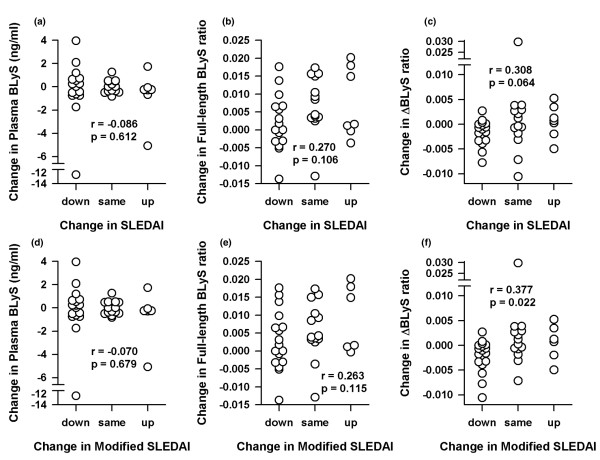
Correlations in SLE patients between changes in SLEDAI and BLyS parameters. Individual (a,d) BLyS protein levels, (b,e) full-length BLyS mRNA levels, and (c,f) ΔBLyS mRNA levels are plotted according to directional changes in SLEDAI scores (a–c) or modified SLEDAI scores (d–f) between the first and second clinical assessments. BLyS, B lymphocyte stimulator; SLEDAI, Systemic Lupus Erythematosus Disease Activity Index.